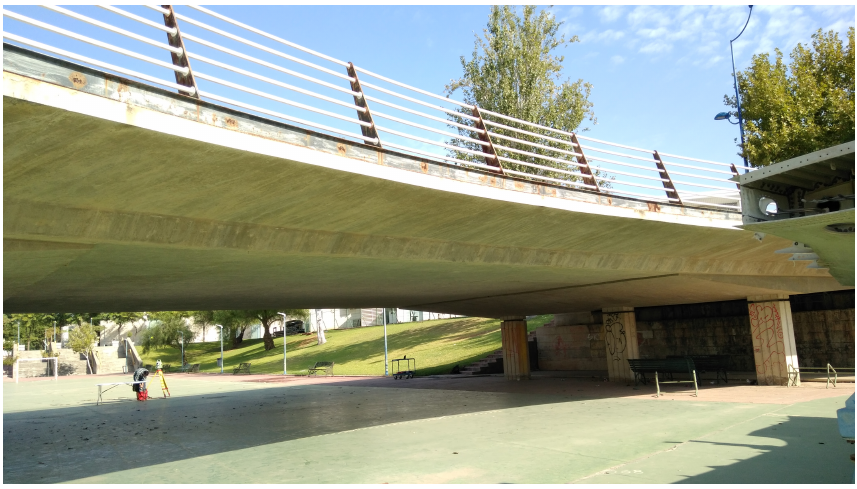
Figure 9. Cartuja bridge.